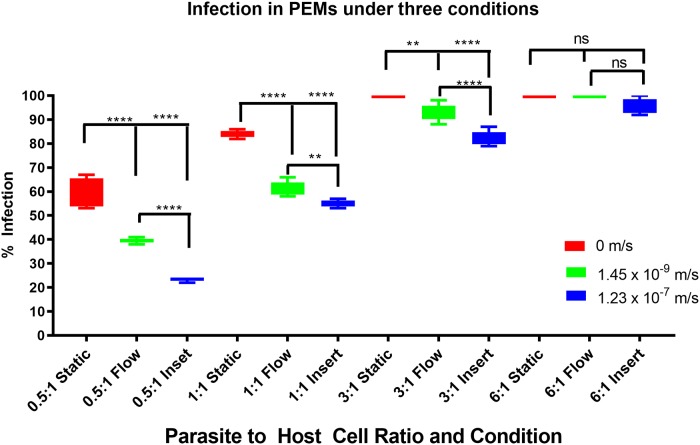
Box and whisker diagram showing the percentage of infected cells over a range of different infection ratios, of parasite: Macrophage number, and different flow conditions.Significance tested using a two tailed t-test p<0.01 = ** p<0.0001 = **** ns = not significant N = 6.